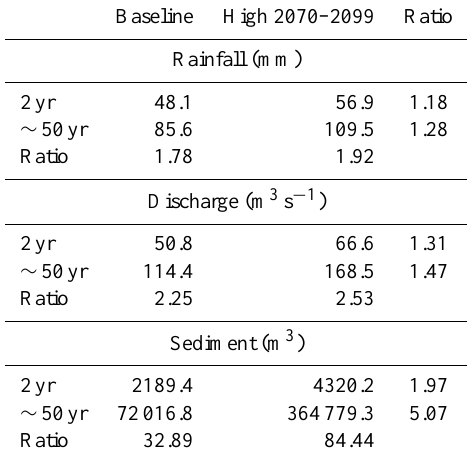
Table 3. Estimated ∼ 50 and 2-yr return periods for daily rainfall (mm), discharge (m 3 s − 1 ) and total sediment (m 3 ) for the baseline and 2070–2099 high emissions scenario showing the changing ratio between the return